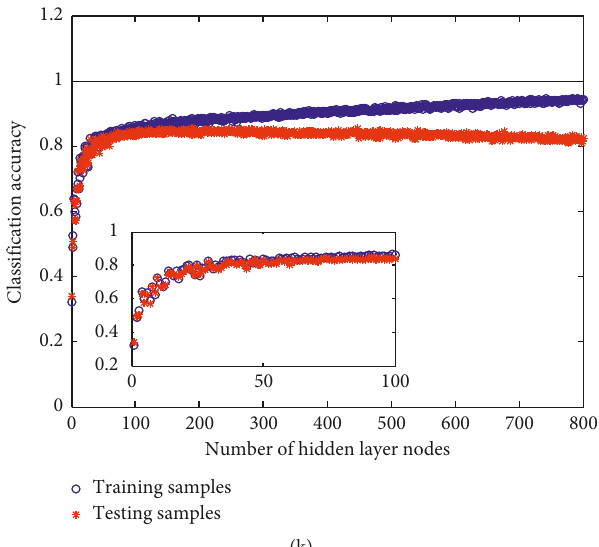
Figure 2: ELM training and testing results of the selected UCI classification data sets: (a) abalone; (b) statlog (heart); (c) diabetes; (d) parkinsons; (e) wdbc; (f) iris; (g) wine; (h) breast tissue; (i) glass; (j) seeds; (k) waveform (version 2).